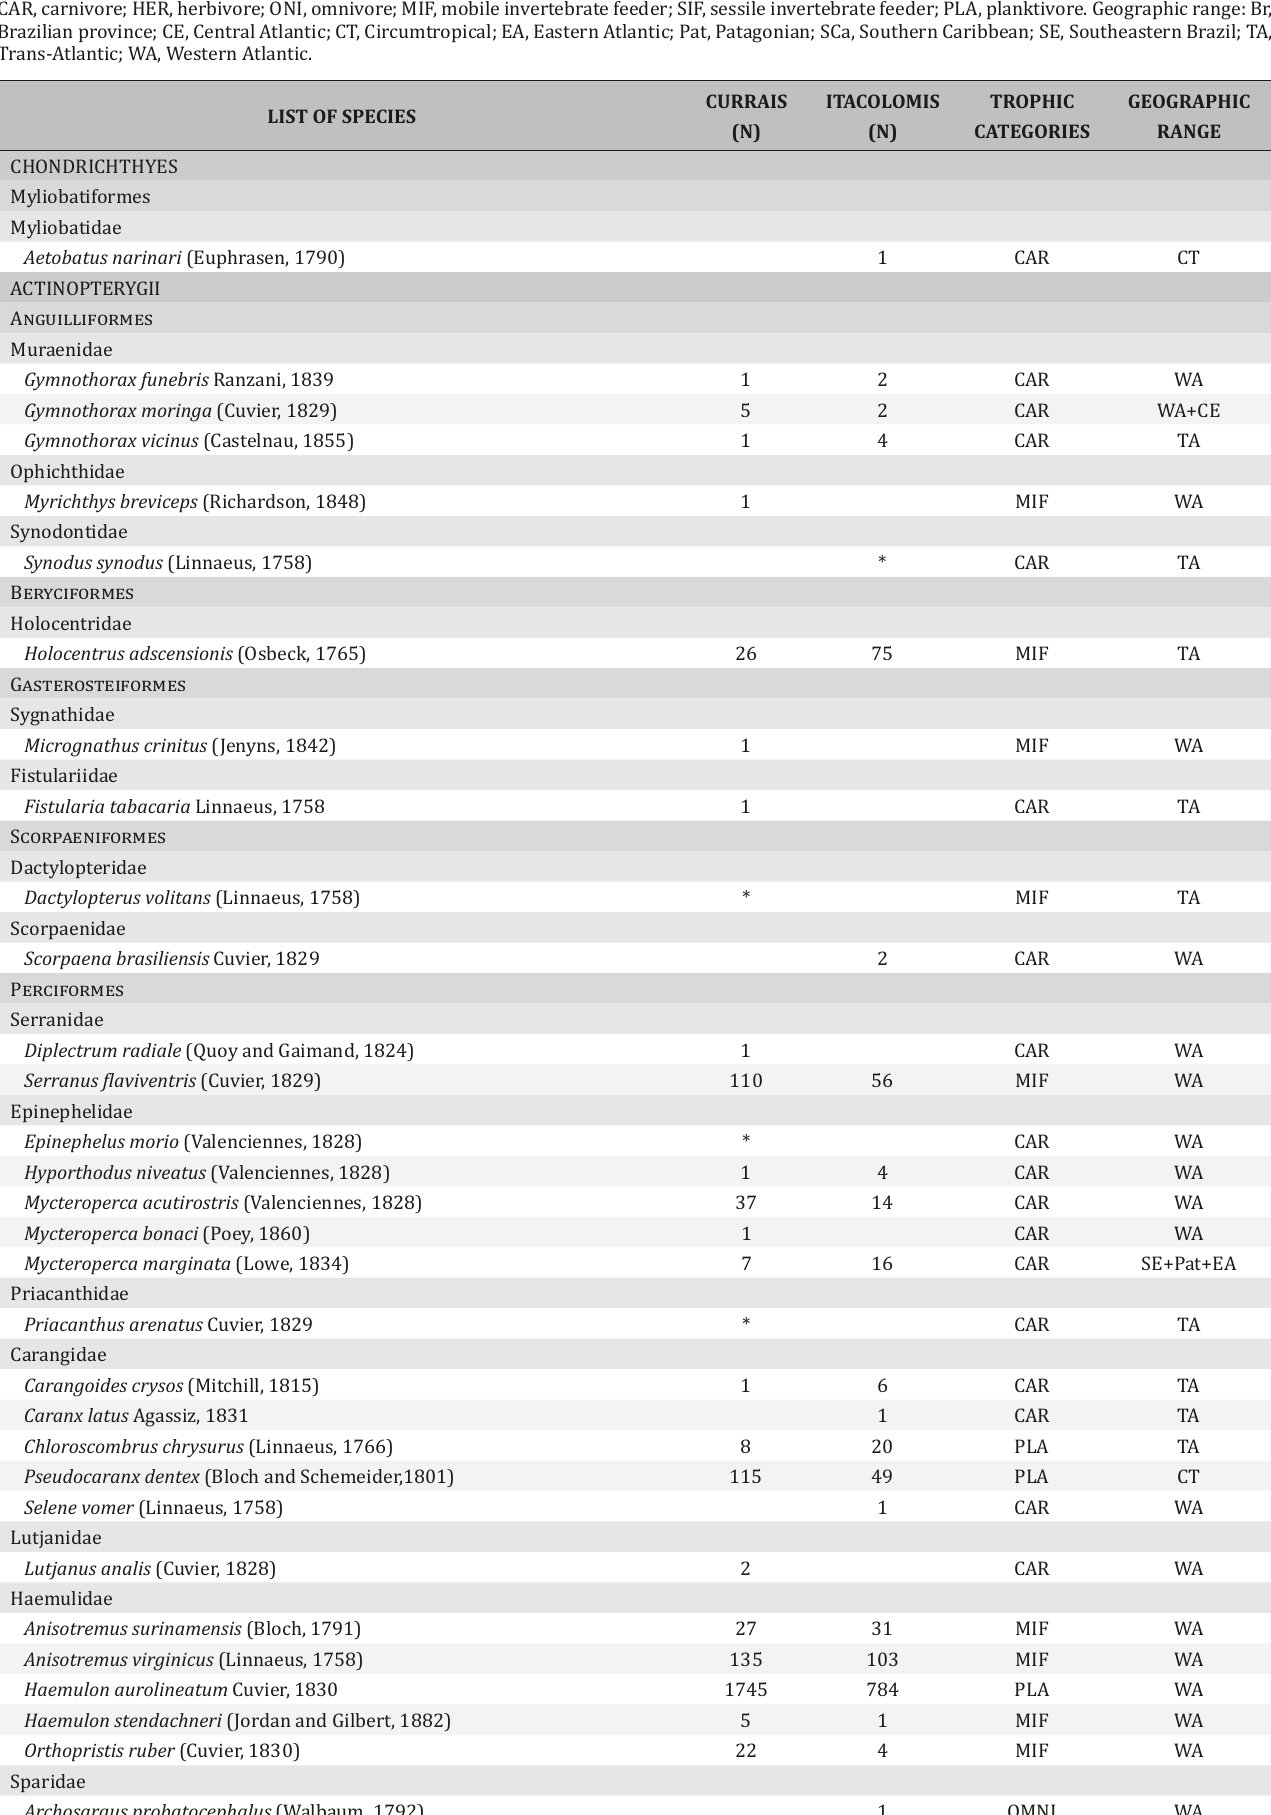
Abundance of species of fishes in the Currais Archipelago and Itacolomis Island. Classification follows Nelson (2006). Trophic categories: CAR, carnivore; HER, herbivore; ONI, omnivore; MIF, mobile invertebrate feeder; SIF, sessile invertebrate feeder; PLA, planktivore. Geographic range: